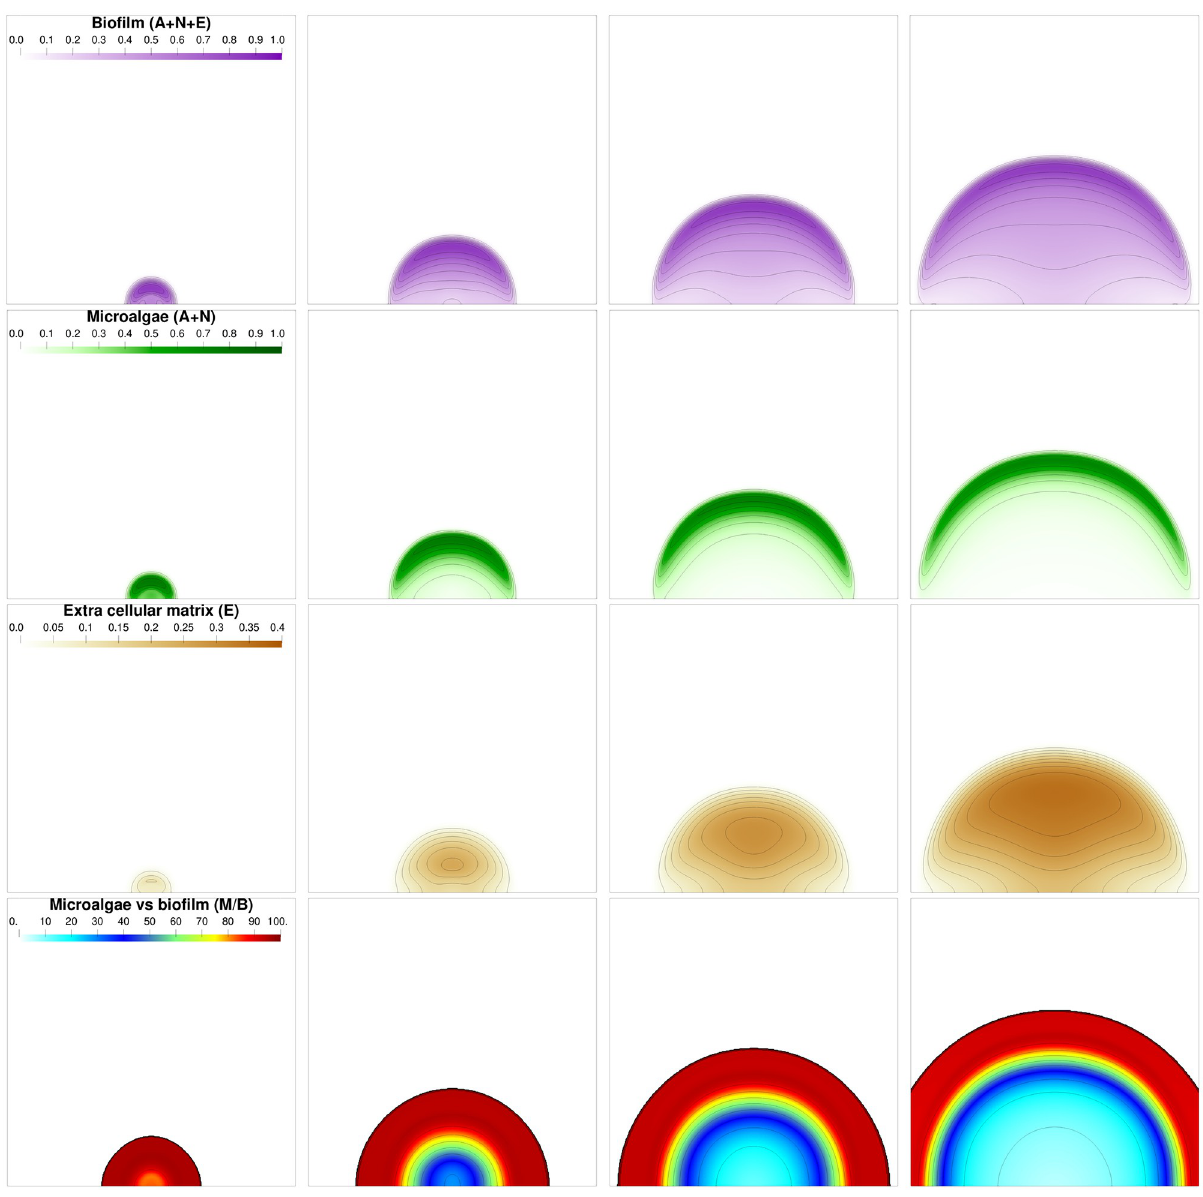
Fig 2. Biofilm volume fractions and composition at different times: t = 5, t = 15, t = 25 and t = 35 days from left to right. The first row represents the whole biofilm volume fraction B = A + N + E . The second row represents the microalgae volume fraction M = A + N . The third row represents the extra cellular matrix volume fraction E . Finally the last row represents the ratio of living biomass over the whole biomass, namely 100 × M / B .